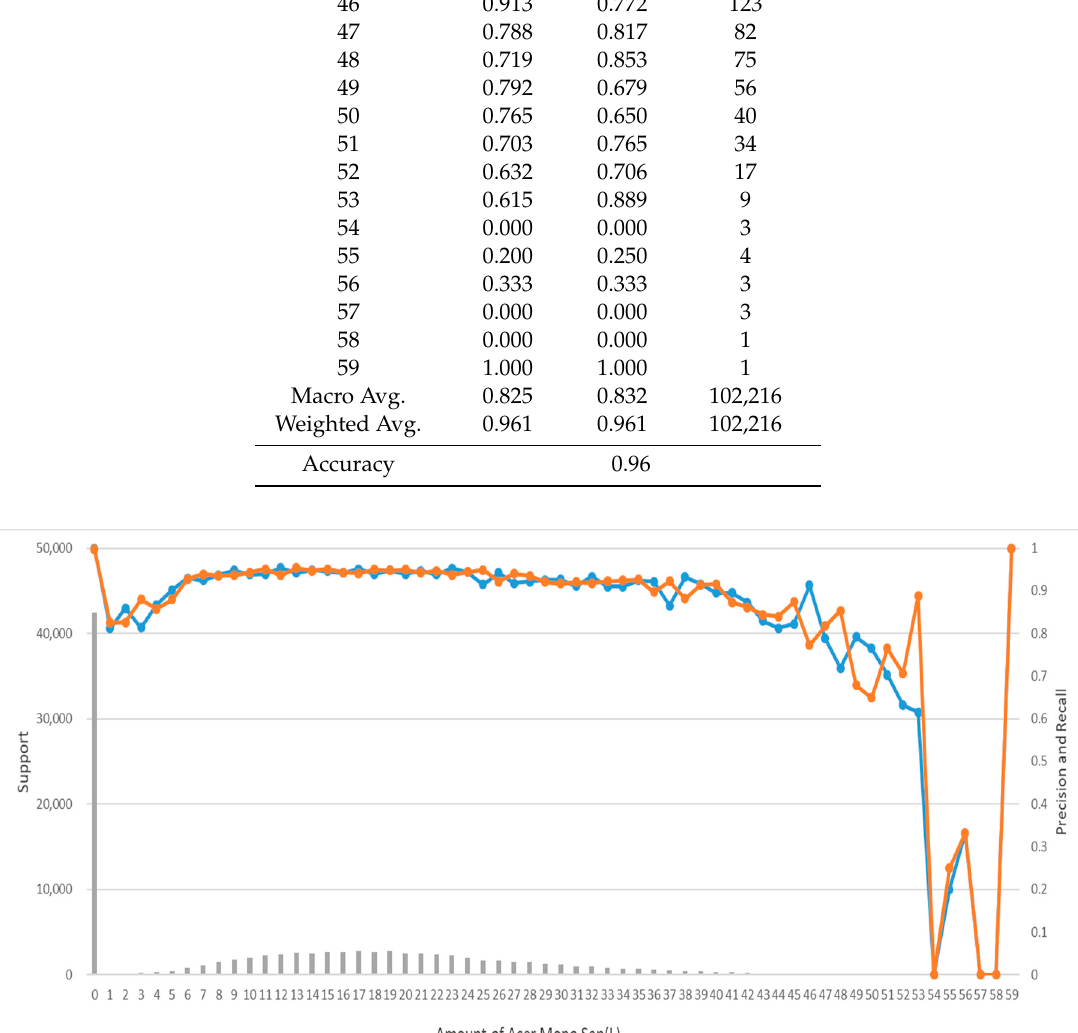
Figure 22. Prediction of sap amount based on Random Forest. 3.4. Comparative Evaluation of Optimal Models Between Predicted Models The optimal models of linear regression, SVM, ANN and random forest algorithms were compared in learning time, prediction time, and accuracy to select one applicable to a mobile app. Learning time represents time required for a model to learn data. It was chosen as a criterion of evaluation for the expandability of a model for additional learning with data collected from Acer mono sap collection devices. Prediction time represents time required for a model to predict Acer mono sap exudation. It was added as a criterion to take into account the time until the outcomes are reflected when users check exudation prediction with a mobile app. Accuracy represents the degree of match between predicted exudation by a model and actual exudation. It was added as another criterion of evaluation to reflect how accurate outcomes can be delivered to users when they check predicted exudation on a mobile app. Table 12 shows the optimal models in learning time, prediction time, and accuracy.